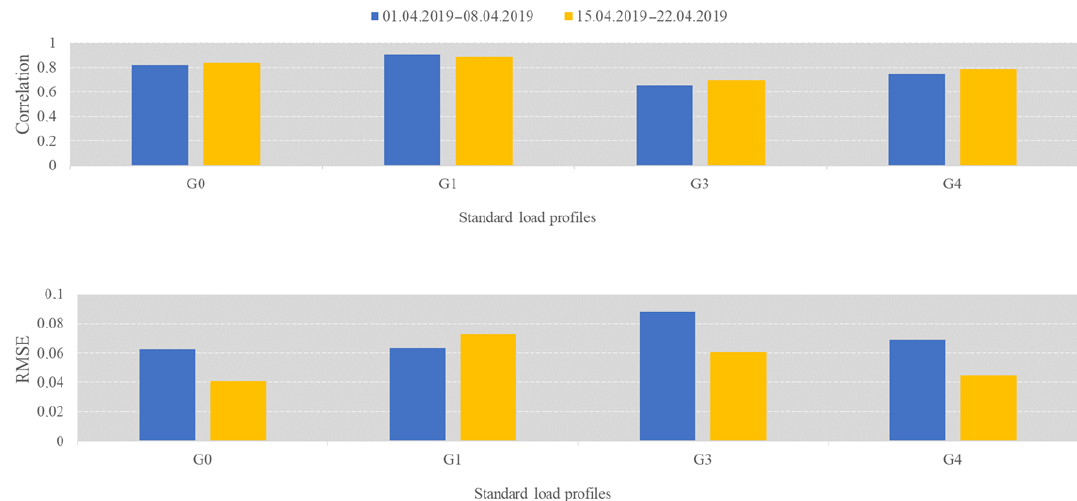
Figure 4. Correlation and root mean square error between a measured load compared to standard load profiles in weekdays and public